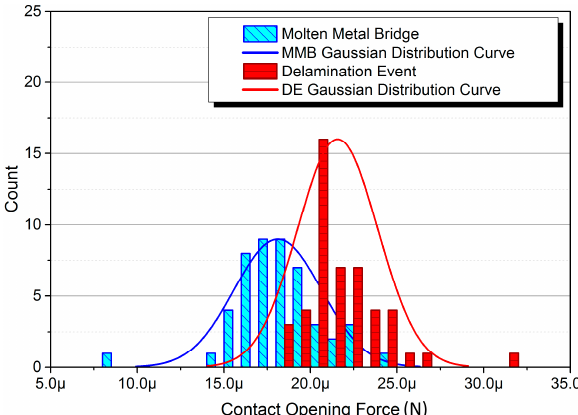
Figure 8. A histogram of the Transient Peak Force of 100 consecutive hot switched contact openings at 4 V 20 mA. Delamination event (DE) are shown in red while molten metal bridge (MMB) are shown in blue. The average Transient Peak Force is 18.1 µ N for MMB and 21.6 µ N for